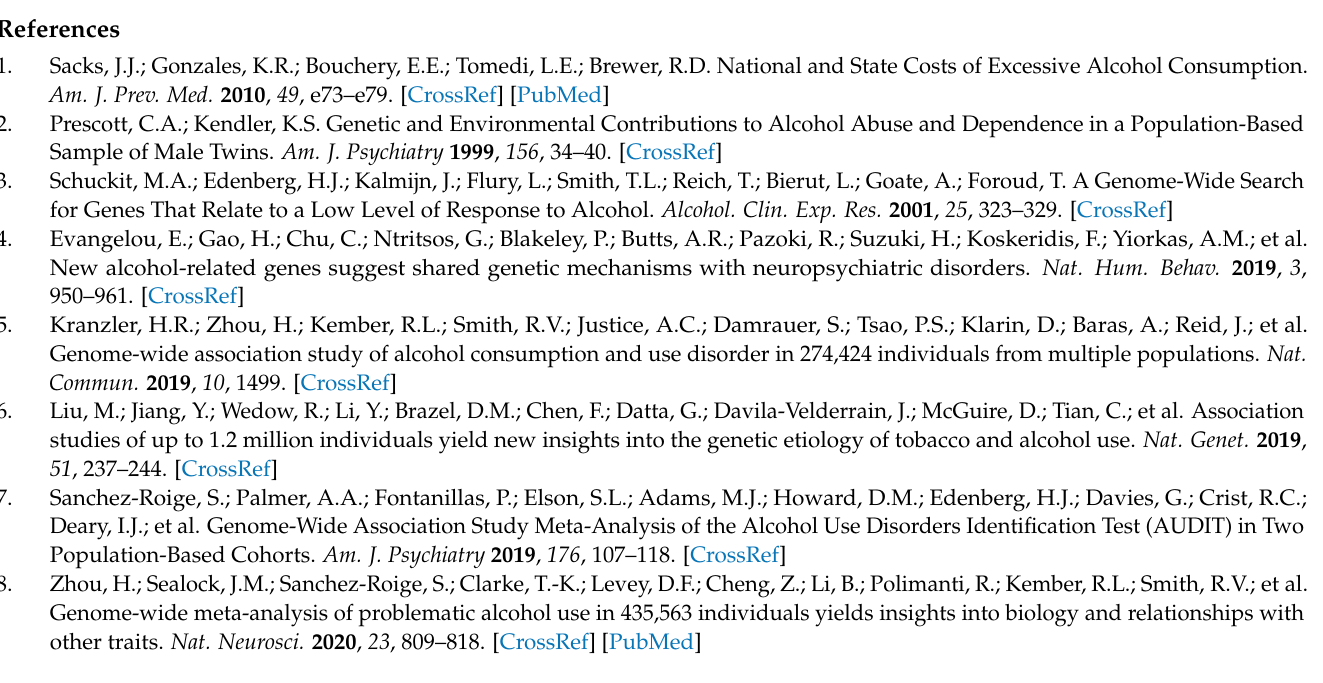
or citric acid cycle), Figure S3: Fatty Acid Biosynthesis, Figure S4: GABA receptor Signaling, Figure S5: Synaptic Vesicle Pathway, Figure S6: Disruption of postsynaptic signalling by CNV (copy number variations, Figure S7: G Protein Signaling Pathways, Figure S8: Chemokine Signalling Pathway, Figure S9: Cannabinoid receptor signaling, Table S1: The study subjects, Table S2: Statistically Table S3: Functional pathway analysis output from g:Profiler’s g:GOSt functional profiler tool, Table S4: Functional pathway analysis output from Gene Ontology GO enrichment analysis tool, Table S5: Functional pathway analysis output from WikiPathways analysis tool, Table S6: Significantly altered genes from the current study that were confirmed having significant associations with AUD and alcohol consumption phenotypes in recent (2019-2020) GWAS studies, Table S7: List of antibodies used in the Western blot